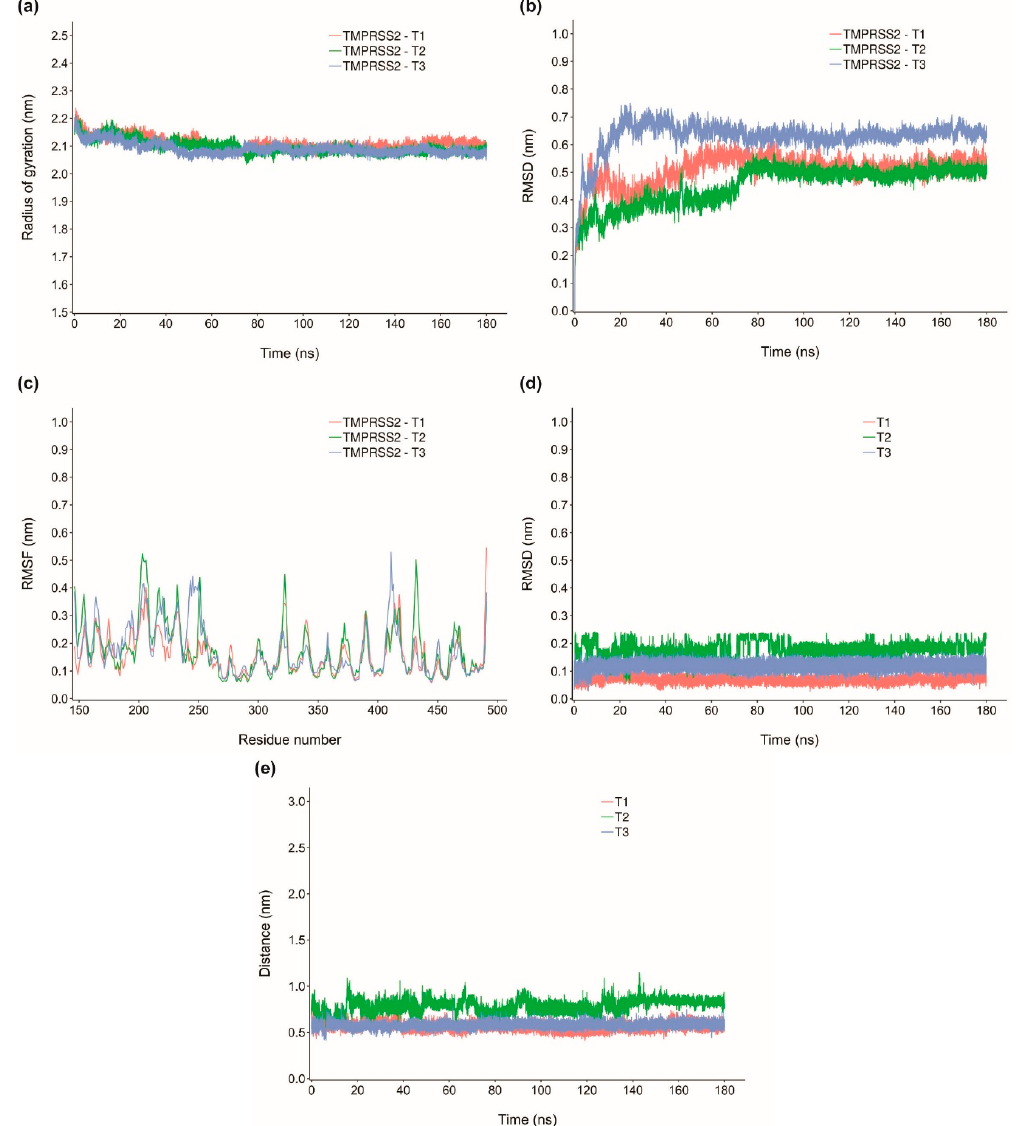
Figure 8. ( a ) Radius of gyration for TMPRSS2 in complex with T1, T2 and T3, ( b ) RMSD for TMPRSS2 in complex with T1, T2 and T3, ( c ) RMSF for TMPRSS2 in complex with T1, T2 and T3, ( d ) RMSD of T1, T2 and T3, and ( e ) Distance of the center of mass of T1, T2 and T3 from the substrate binding residue D435 in TMPRSS2.